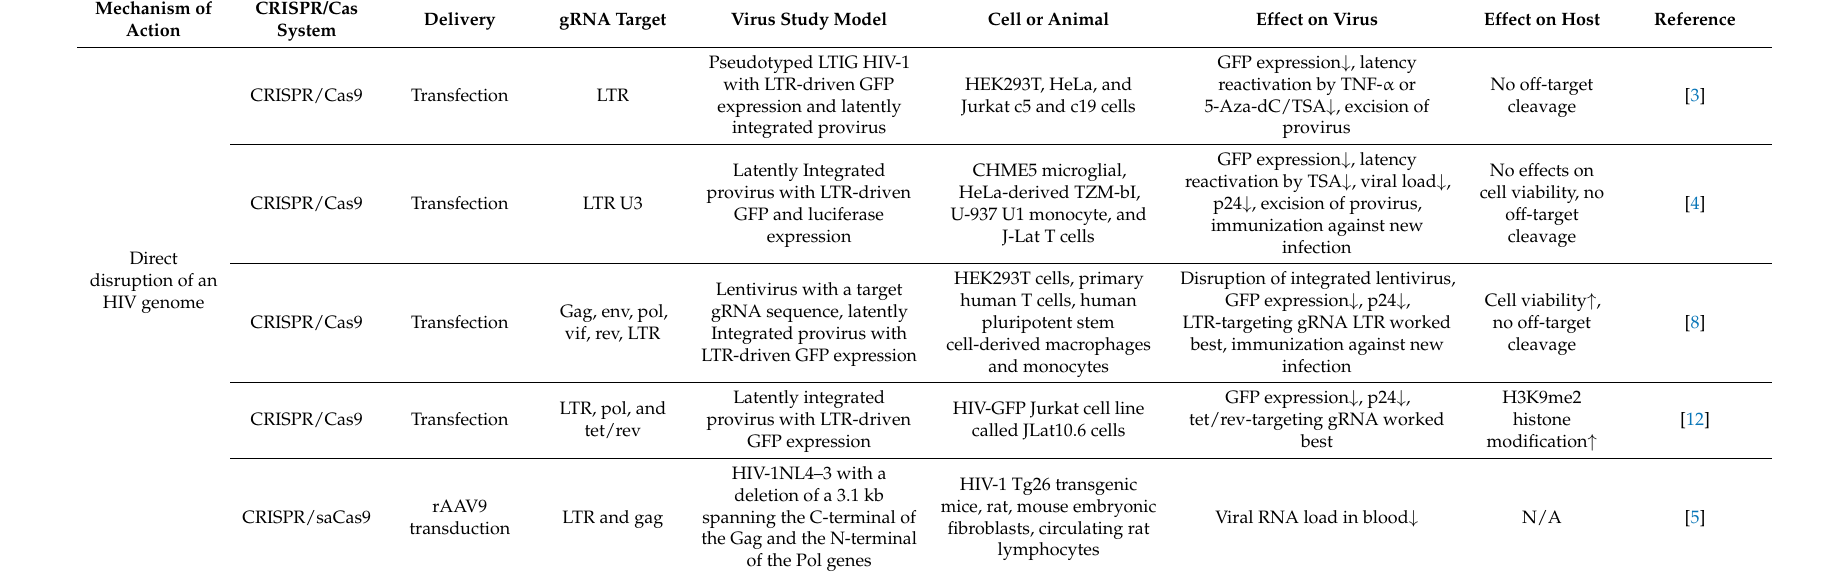
Table 1. Summary of CRISPR/Cas9-based antiviral studies targeting HIV-1. These anti-HIV studies were sub-classified based on their antiviral mechanism of actions. Abbreviations used within the table are as follows. CRISPR/Cas; clustered regulatory interspaced short palindromic repeat-associated nucleases, saCas9; Cas9 from Staphylococcus aureus , Cas9n; Cas9 nickase, gRNA; guide RNA, LTR; long terminal repeat, HIV-1; human immunodeficiency virus-1, GFP; green fluorescence protein, HEK293T; human embryonic kidney 293 cells with SV40 large T antigen, TNF- α ; tumor necrosis factor alpha, 5-Aza-dC; 5-aza-2 (cid:48) -deoxycytidine, TSA; trichostatin A, AAV; adeno-associated virus, LV; lentivirus, PBMC; peripheral blood mononuclear cell, PMA; phorbol 12-myristate 13-acetate, Tat; tetracycline, Luc; luciferase, NOD/SCID; non obese diabetic-severe combined immunodeficiency, SAHA; suberoylanilide hydroxamic acid, HSF1; heat shock factor 1, SAM; synergistic activation mediator, CCR5; chemokine receptor type 5, HDAC; histone deacetylase, NF-kB, nuclear factor kappa B, CCR2; chemokine receptor type 2, iPSC; induced-pluripotent stem cell, CXCR4; C-X-C chemokine receptor type 4, IFN; interferon, ISG; interferon-stimulated gene, PD-1; programmed death-1, CTLA-4; cytotoxic T-lymphocyte-associated protein 4, APOBEC3G; apolipo-protein B mRNA editing enzyme, catalytic polypeptide-like, Fluc; firefly luciferase, TRIM5 α ; tripartite motif-containing protein 5 alpha, VSV; vesicular stomatitis virus, WT; wild type, RT; reverse transcriptase, TAR; trans-activation response, RRE; rev-response element, IRES; internal ribosomal entry site, N/A; not applicable, ↑ ; up-regulation, and ↓ ;